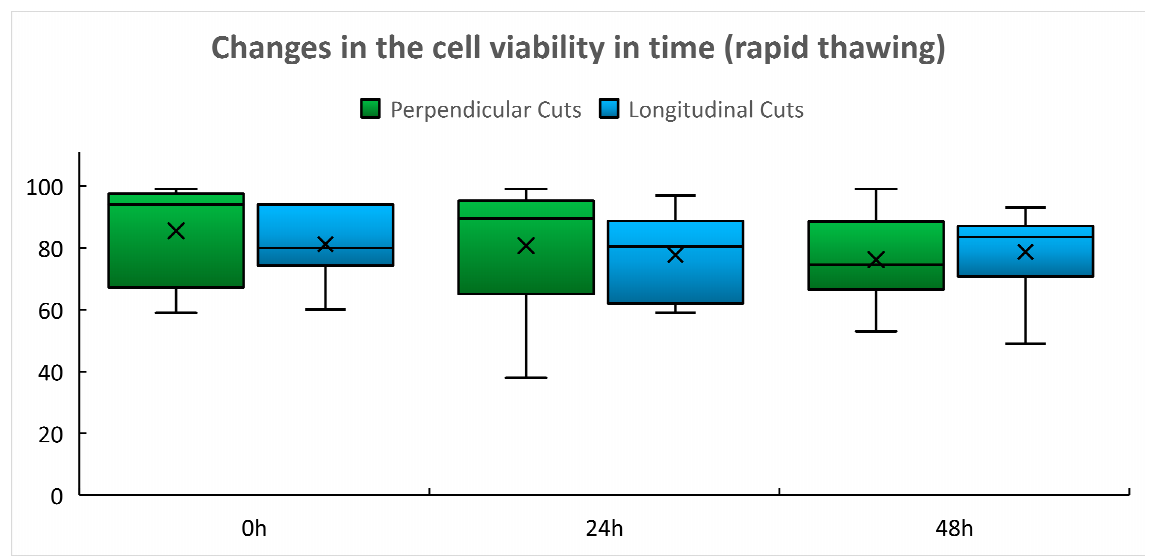
Figure 3. Changes in the post-thaw cell viability in time—rapid thawing